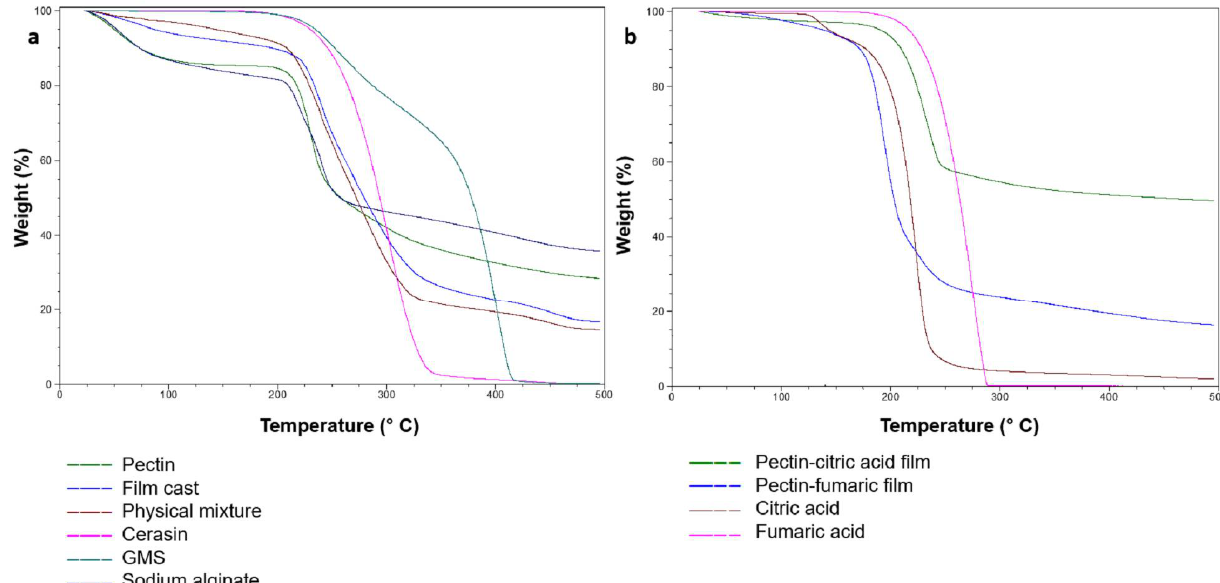
Figure 3. TGA thermographs of ( a ) single components of coating system, physical mixture, and casted film (F2); ( b ) organic acids and their casted film.